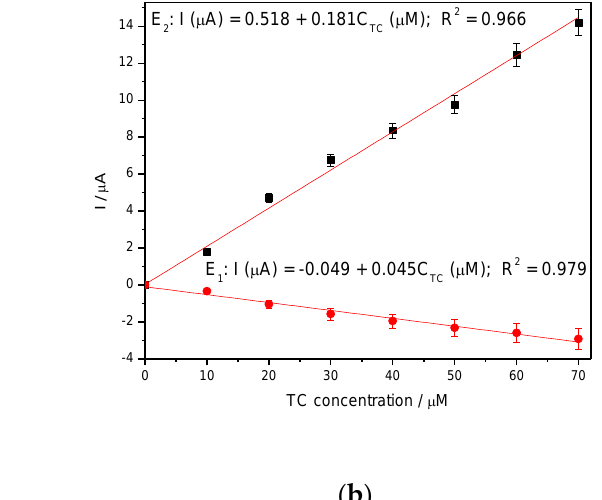
3 = +0.3 V/SCE and E 4 = +0.500 V/SCE vs. TC concentra-